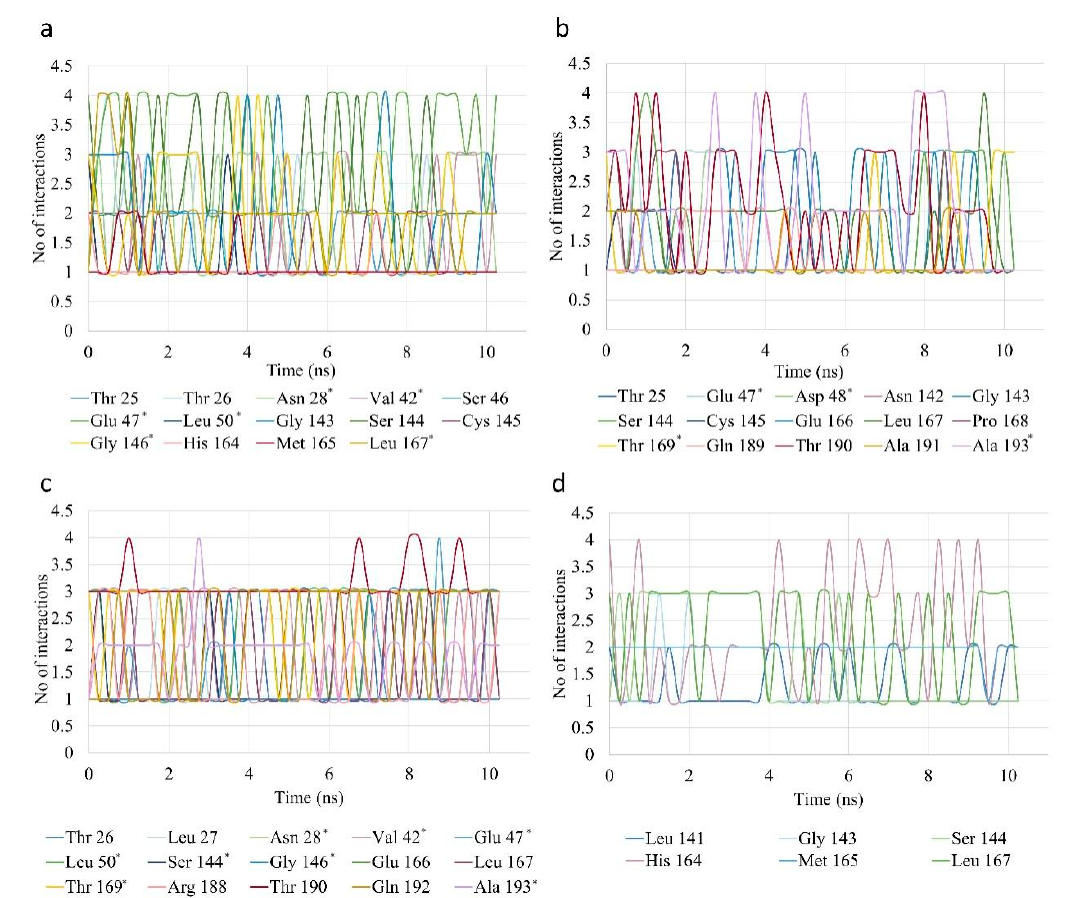
Figure 13. Number of contacts of the ligands ( a ) FA rutinoside, ( b ) raffinose ferulate, ( c ) compound e27, and ( d ) N3 with M pro residues throughout the simulation time. The residues marked with an asterisk (*) are residues that appeared to have contact with the ligand in the MD simulation but were not given as contacting residues in the molecular docking simulation output. However, they are neighboring contacting residues. This can be due to the fact that since MD trajectory analysis uses the distance as a parameter to calculate contacts, sometimes atoms from neighboring residues can be within a distance small enough to be regarded as contacts.